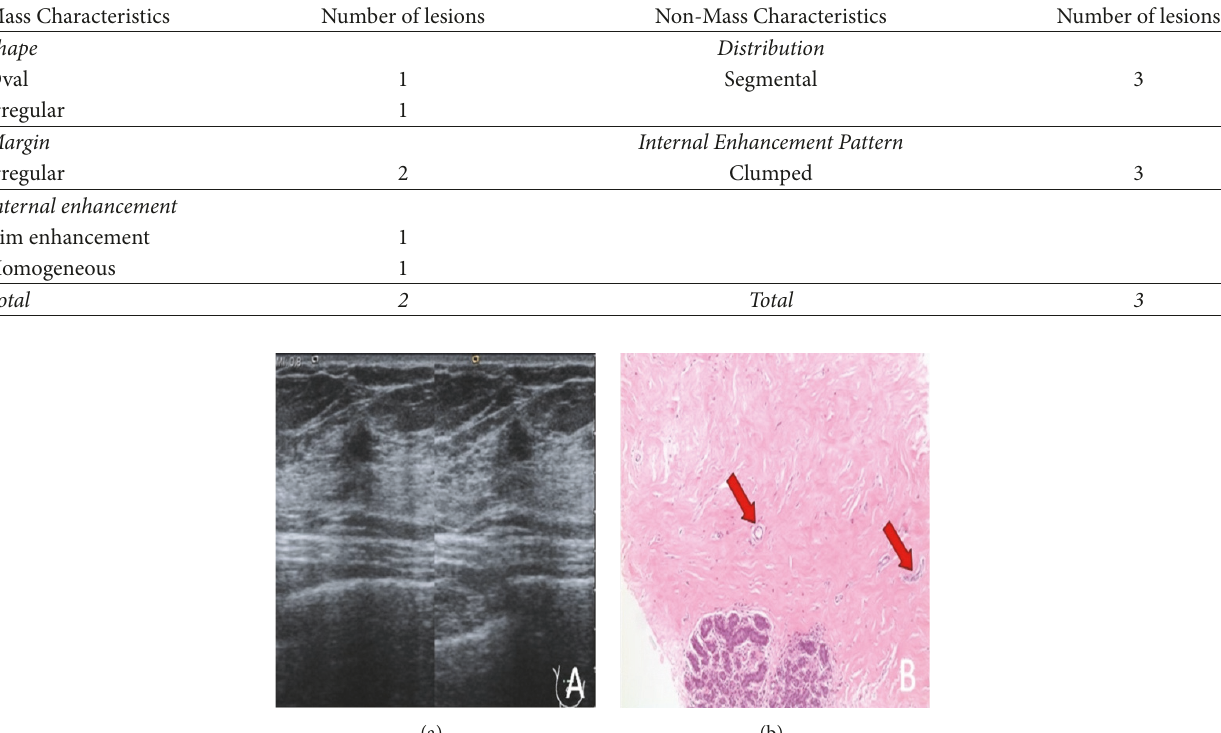
Table 3: MRI findings.